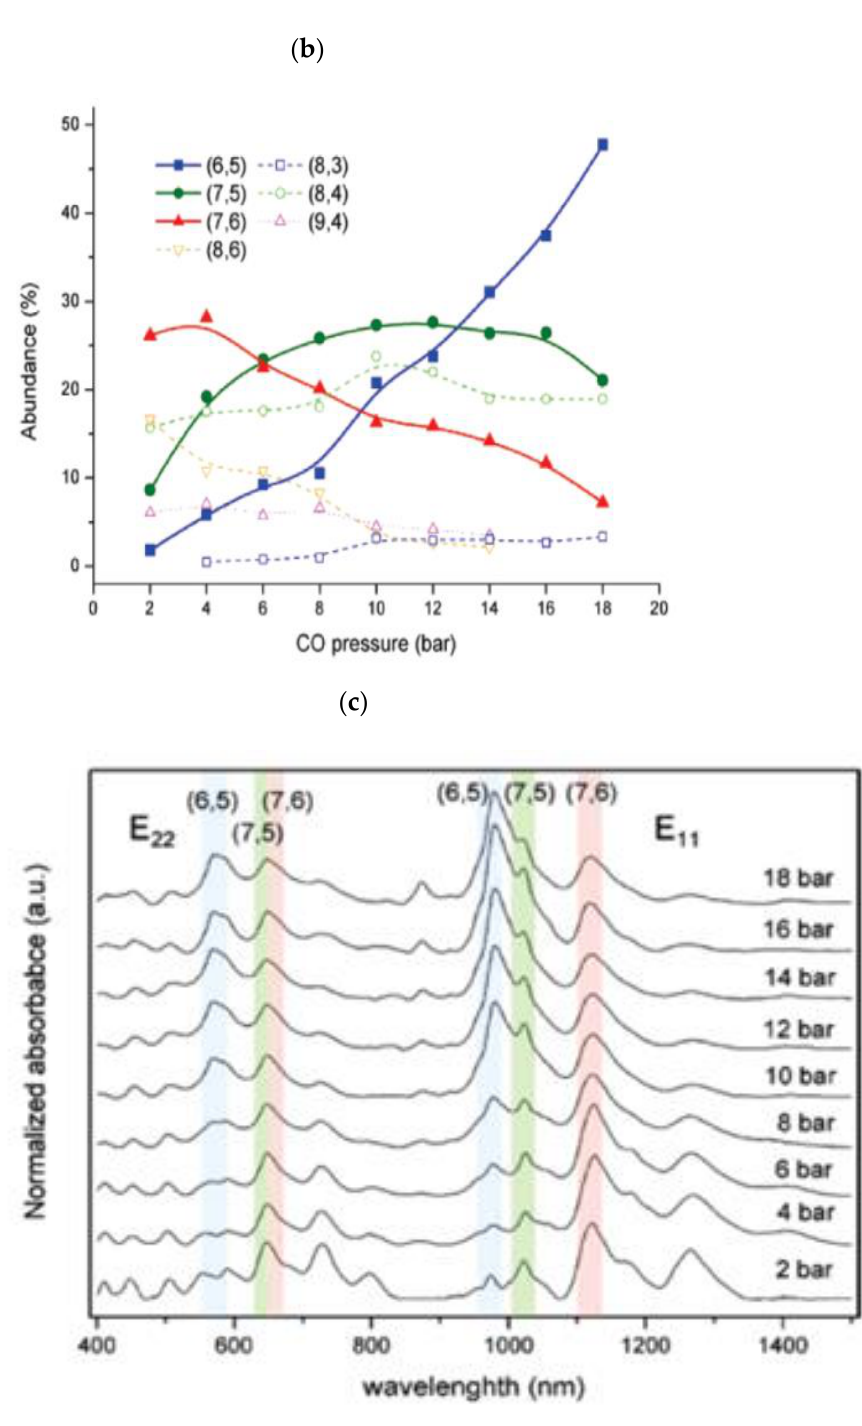
Figure 5. ( a ) PL maps of SWCNT grown under CO pressures between 2 and 18 bar. The labels indicate three dominant chiralities. ( b ) Abundances of SWCNT with different chiralities versus changing CO pressure. ( c ) Optical absorption spectra of SWCNTs obtained under a different CO pressure. The first and second absorption peaks are highlighted, indicating the change in the three main chiralities’ intensities [37]. Copyright 2007, American Chemical Society.